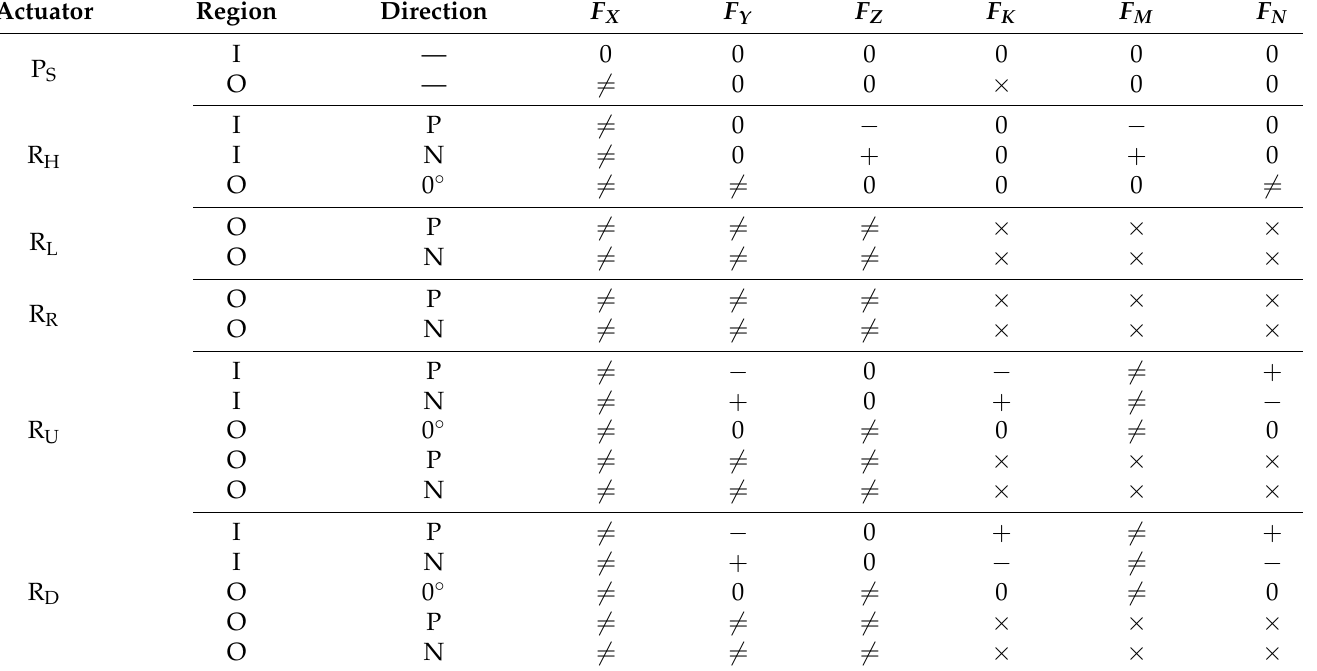
Table 3. Integrated fault features of propeller and